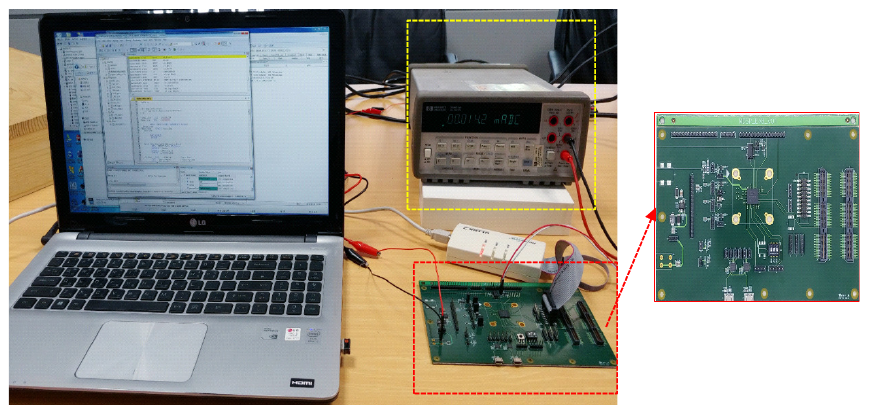
Figure 10. Verification platform of the sensor signal processing SoC.